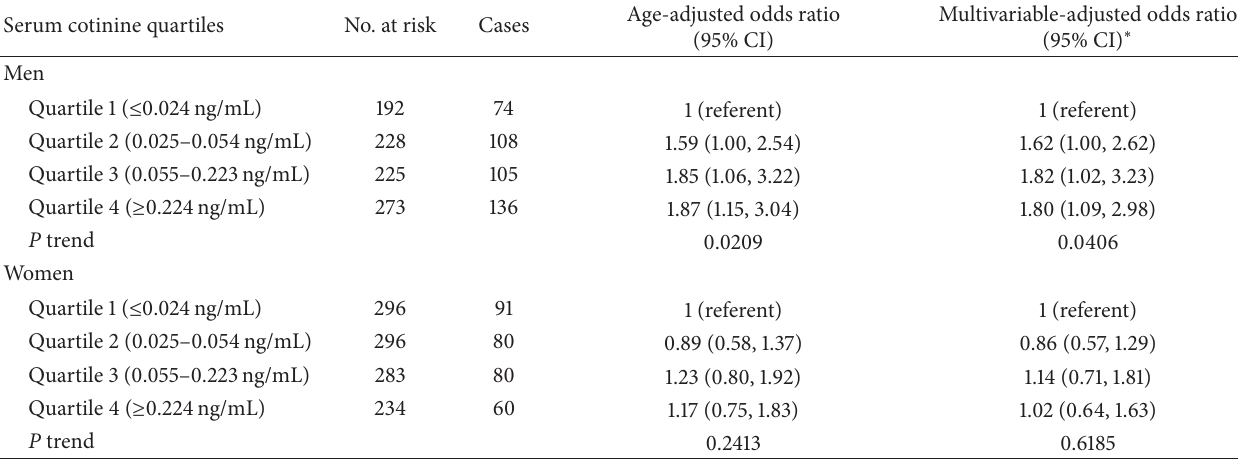
Table 3: Association between serum cotinine levels and prehypertension, by